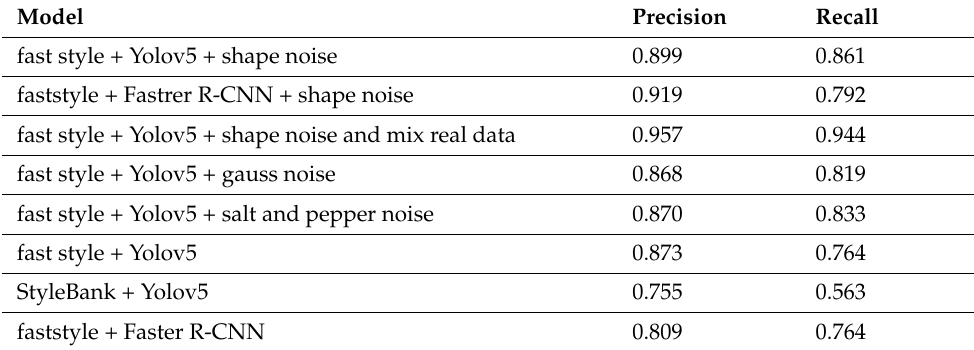
Table 6. Comparison of model in precision and recall.